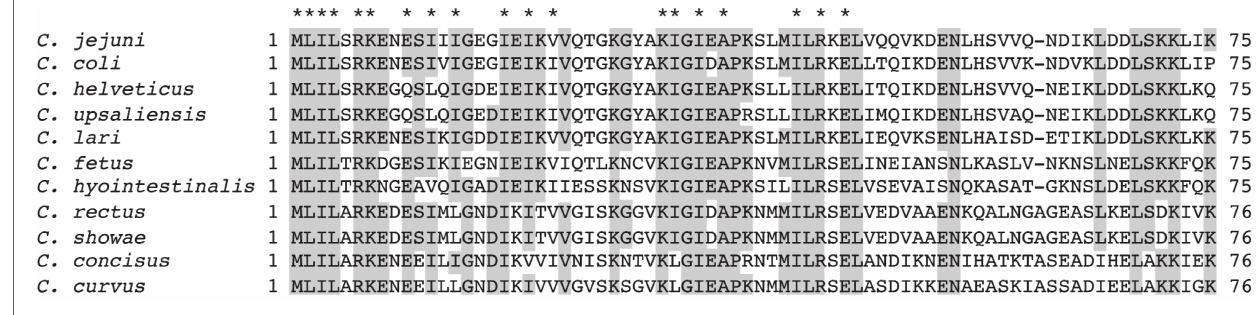
FIGURE 9 | Alignment of CsrA proteins from 11 Campylobacter species. CsrA proteins (75 or 76 amino acids in length) from 11 representative Campylobacter species were aligned using Clustal Omega (Li et al., 2015). Amino acids that are identical in at least 7 of 11 orthologs are shaded gray. The amino acids identified as having roles in RNA binding by C. jejuni CsrA are indicated above the alignment by asterisks and are highly conserved among Campylobacter CsrA